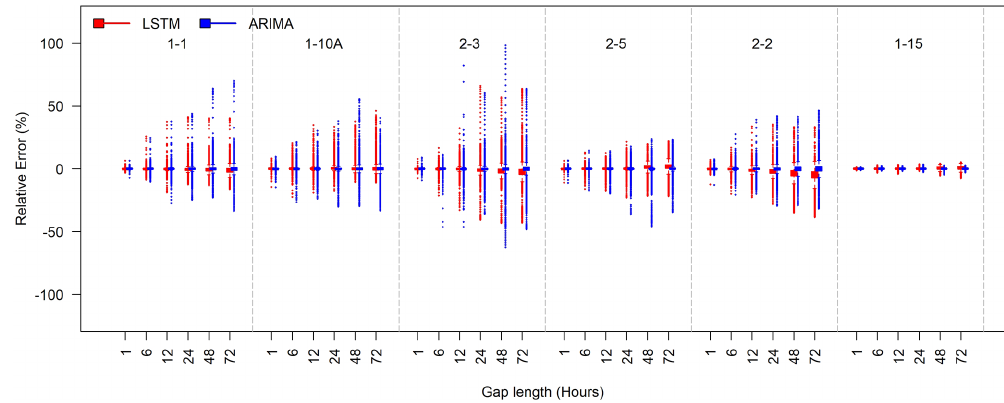
Figure 7. Box plots of the relative errors for filling SpC gaps of various lengths (1, 6, 12, 24, 48, and 72h) at each well during the test periods. The best LSTM and ARIMA models were used for evaluation. The LSTM and ARIMA models are represented by red bars and blue bars,